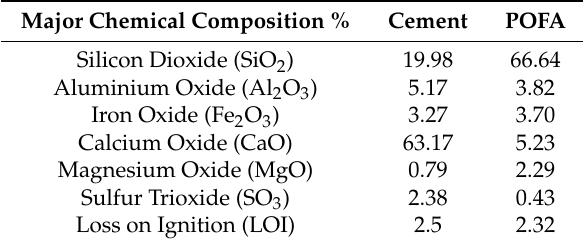
Table 1. Comparison of chemical compositions of Portland cement and palm oil fuel ash [25].